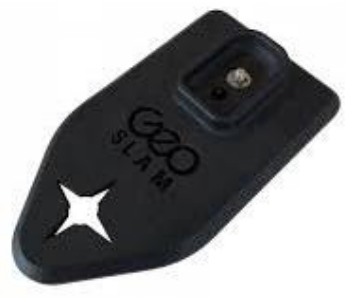
Figure 2. GeoSLAM control point alignment device.